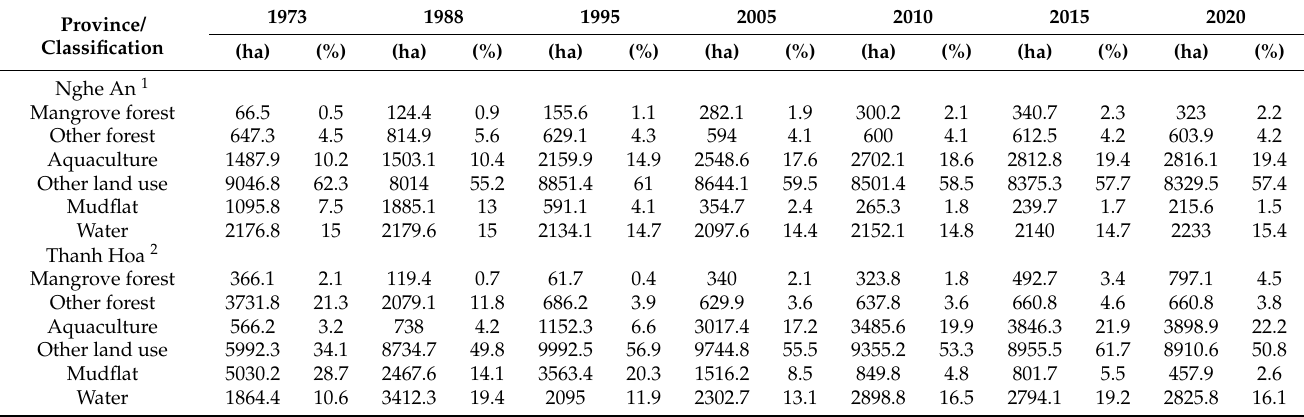
Table 4. The estimated area of LULC (ha) and the land cover percentages in Nghe An and Thanh Hoa provinces for the years 1973, 1988, 1995, 2005, 2010, 2015, and 2020 obtained from Landsat images. Province/ Classification